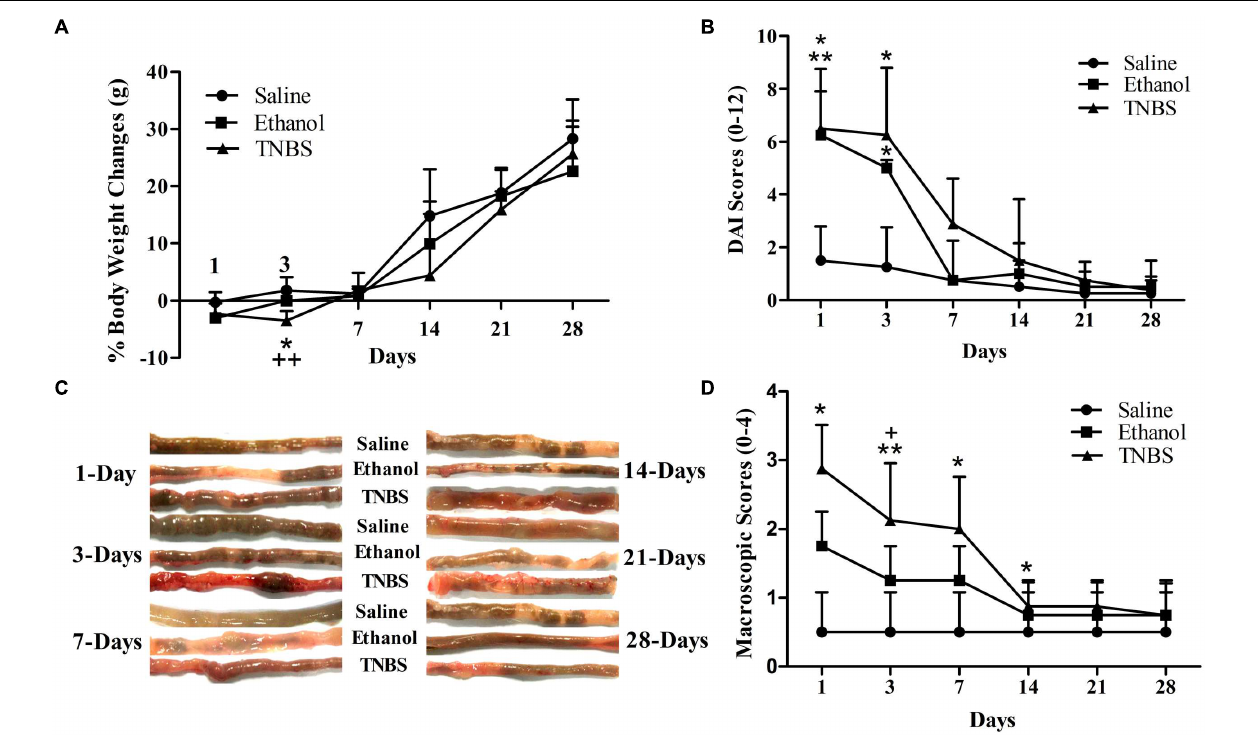
FIGURE 2 | Effects of TNBS administration on body weights and macroscopic pathologic changes in rats. Body weight changes. ∗ P < 0.05, TNBS group vs. Saline group; ++ P < 0.01, TNBS group vs. Ethanol group; One-way ANOVA followed by Bonferroni’s post-test (A) . Scores of DAI ranging from 0 (healthy) to 12 (maximal severity of ileitis): body weight (0–4), stool consistency (0–4), and rectal bleeding (0–4) (B) . Macroscopic pathologic changes at day 1,3,7,14,21, and 28 (C) . Macroscopic change scores on a scale of 0–4 (D) . ∗∗ P < 0.01, ∗ P < 0.05; TNBS group/Ethanol group vs. Saline group. + P < 0.05; TNBS group vs.